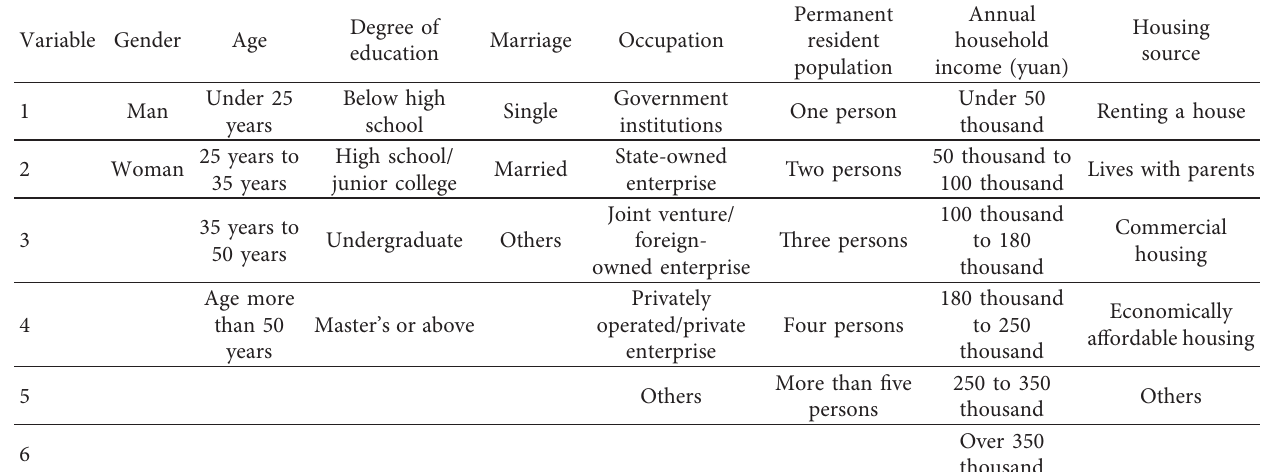
Table 1: Variable classification table.